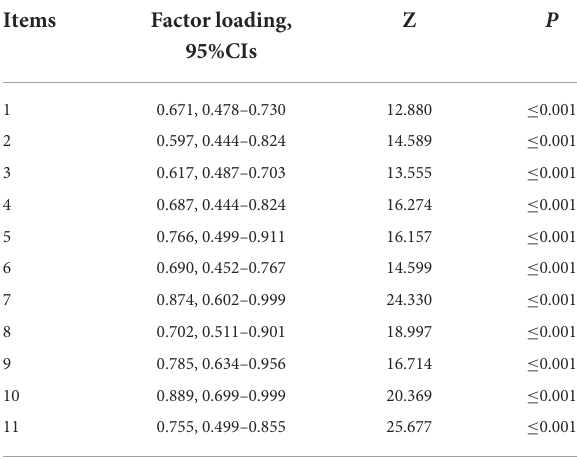
TABLE 1 Item’s factor loading of the CL- BPFSC-SF.